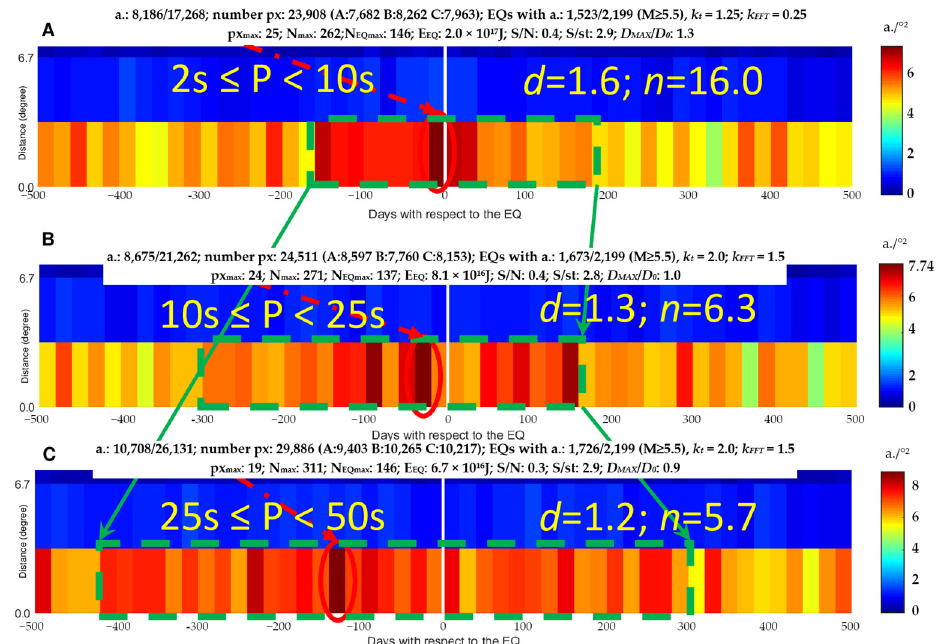
Figure 3. 8-year Swarm Y-mag data separated for frequency content in the anomalies correlated with M5.5+ earthquakes from 500 days before until 500 after their occurrence. The color bar represents the density of the anomalies in terms of the number of anomalies per square degree. The anomalies have been selected with higher signal content in three different period bands: ( A ) from 2 s to 10 s, ( B ) from 10 s to 25 s and ( C ) from 25 s to 50